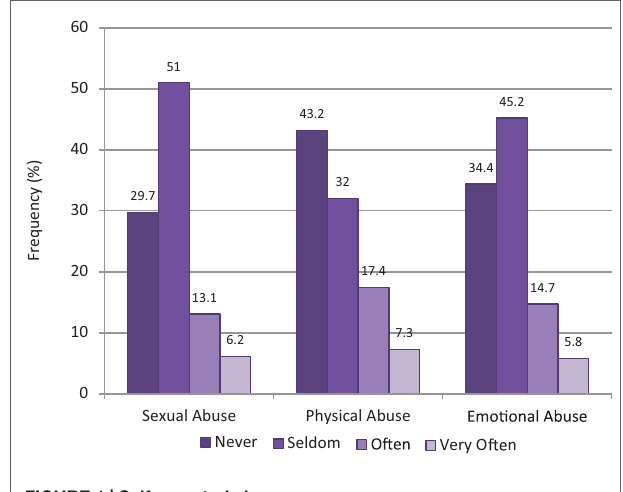
FigUre 1 | self-reported abuse .